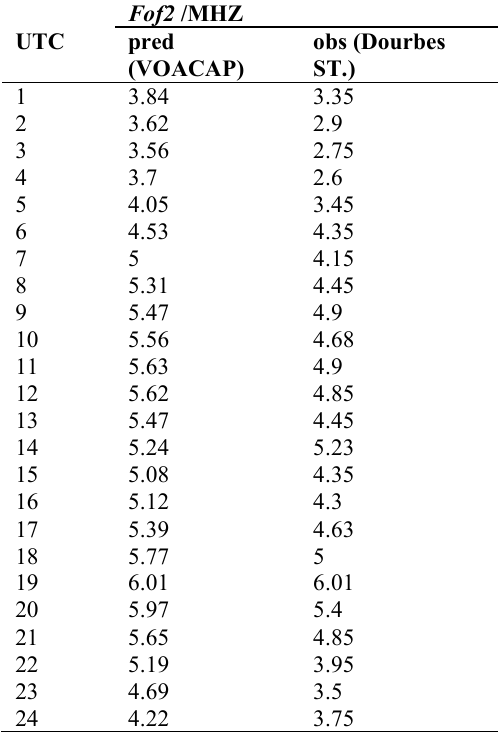
Shows the fof2 predicted and measured